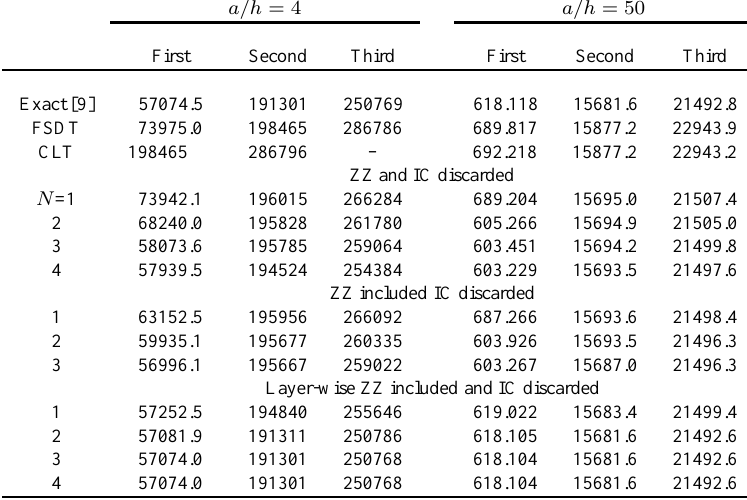
Table 5 Piezoelectric plate: first three circular frequencies ω/ 100 for a/h = 4 and a/h = 50